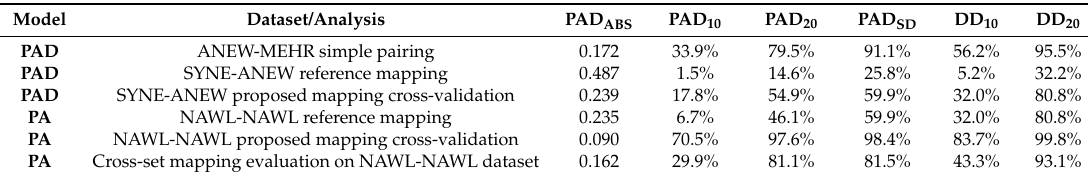
Table 11. Mapping accuracy metrics for ANEW-MEHR